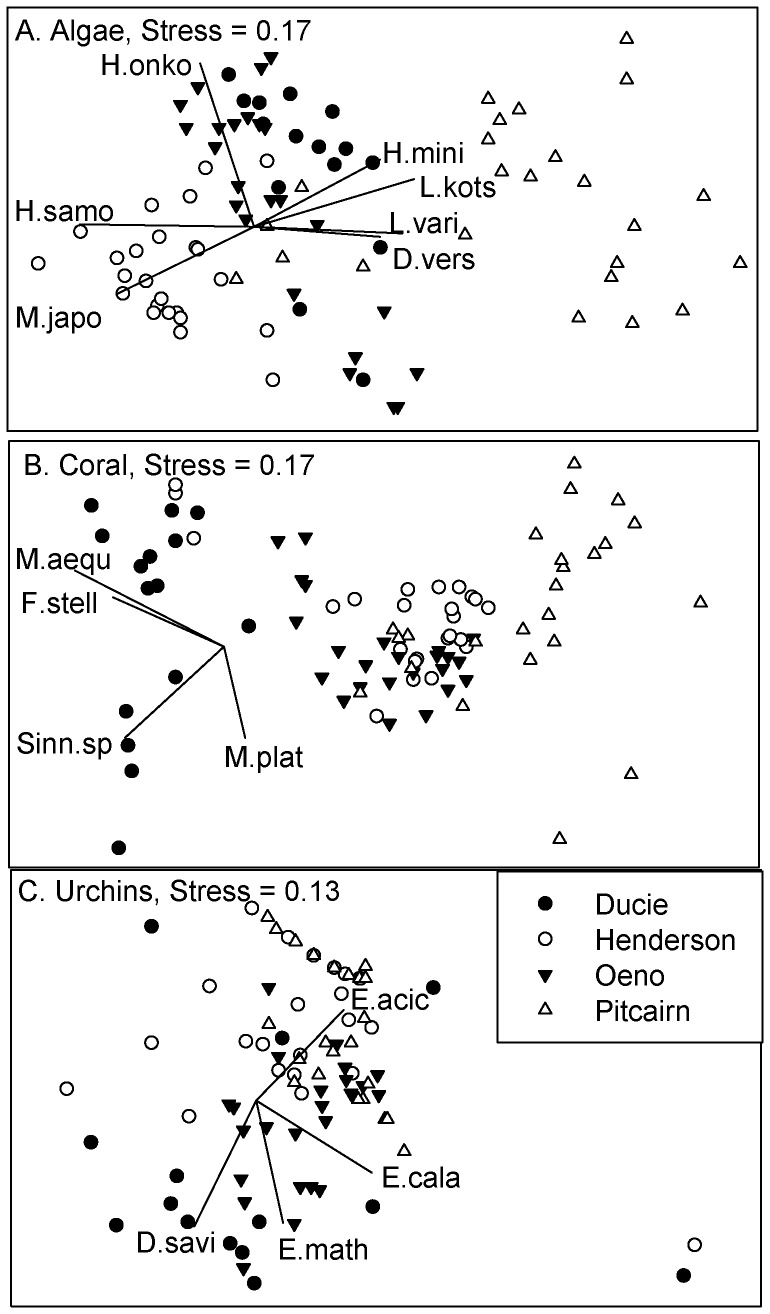
Non-metric multidimensional scaling of major benthic function groups and sampling locations among the four islands in the Pitcairn Group.A. macroalgae, B. corals, C. urchins. Vectors are the primary taxa driving the ordination (Pearson Product movement correlations ≥ 0.5). Macroalgae species codes: D.vers  =  Dictyosphaeria versluysii, H.onko  =  Hydrolithon onkodes, H. mini  =  Halimeda minima, H.samo  =  Hydrolithon samoense, M.umbr  =  Microdictyon japonicum, L. vari  =  erect Lobophora variegata. Coral species codes: F.stell  =  Favia stelligera, M.aequ  =  Montipora aequituberculata, M.plat  =  Millepora plathyphylla, Sinn.sp  =  Sinularia sp. Urchins: D.savi  =  Diadema savignyi, E.mata  =  Echinometra mathaei, E.acic  =  Echinostrephus aciculatus, E.cala  =  Echinothrix calamaris.